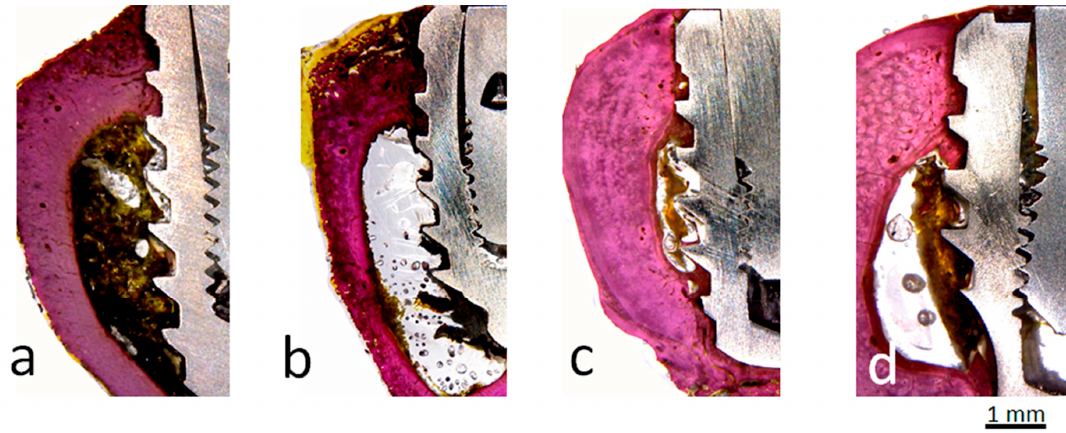
Figure 10. Representative images of the groups 15 days after the implantations. ( a ) G1 group, ( b ) G2 group, ( c ) G3 group, ( d ) G4 group. Images obtained by light microscopy with magnification of 10x.